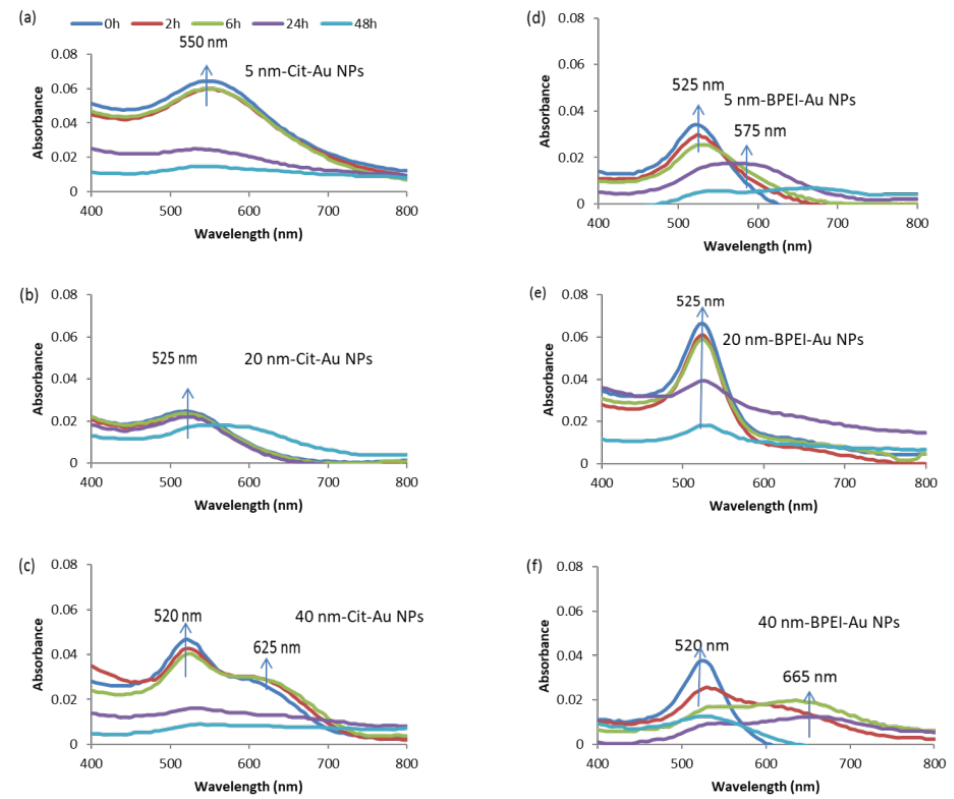
Figure 2. UV-vis spectra analysis of gold NPs in 10% Hoagland’s medium as a function of time, ( a ) 5 nm Cit-nAu, ( b ) 20 nm Cit-nAu, ( c ) 40 nm Cit-nAu, ( d ) 5 nm BPEI-nAu, ( e ) 20 nm BPEI-nAu, and ( f ) 40 nm BPEI-nAu. Data is presented as means ( n = 3). Arrows show the position of the main peak.